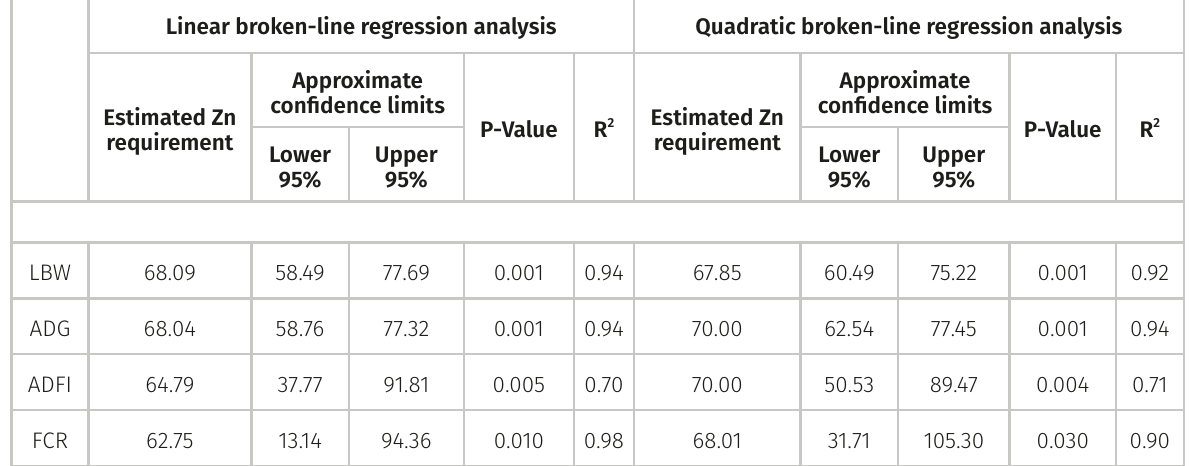
Table VIII. Summary of Zn requirements (mg/kg of diet) for optimization of performance responses estimated by the liner and quadratic broken-line regression fit models in broiler chickens fed wheat-soy diet. Linear broken-line regression